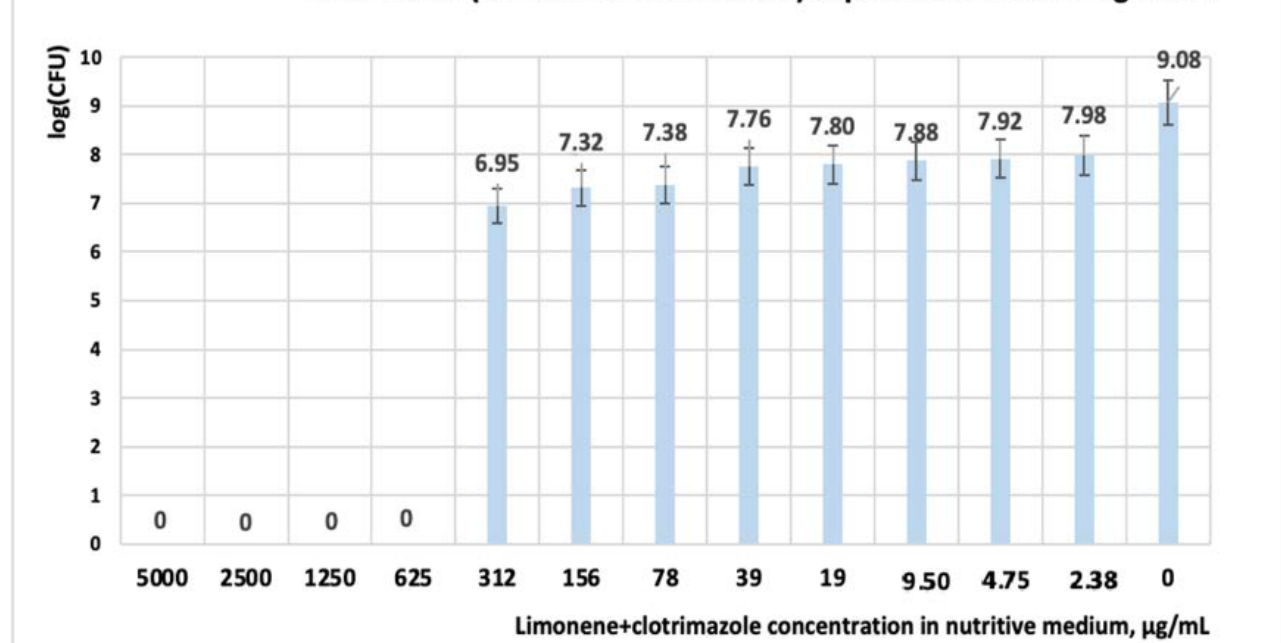
Figure 4. Influence of (limonene + CT) exposure on S. aureus growth, after 24 h. At a concentration of clotrimazole in the culture medium higher than 312 μg/mL, S. aureus is inhibited.